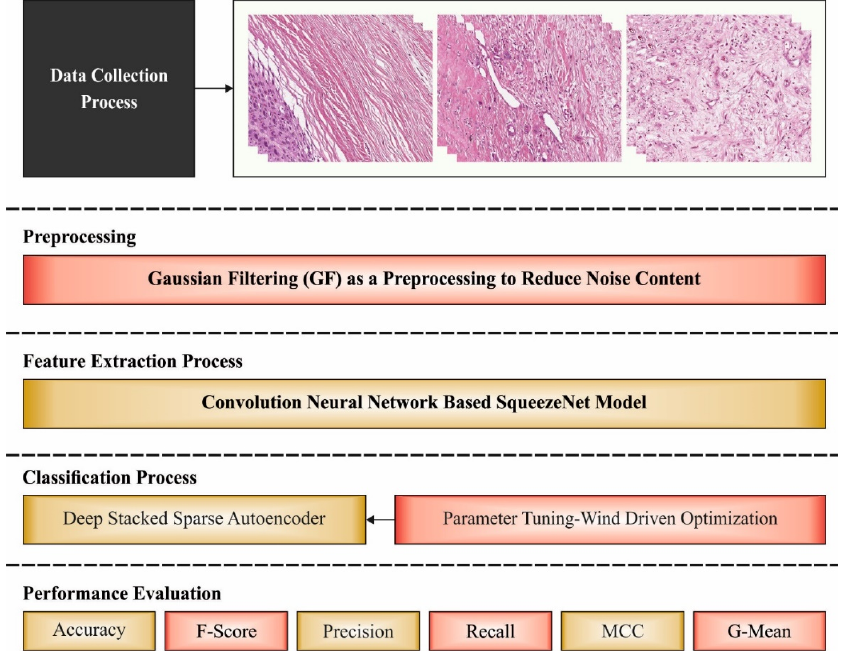
Figure 1. Overall process of WDODTL-ODC technique.